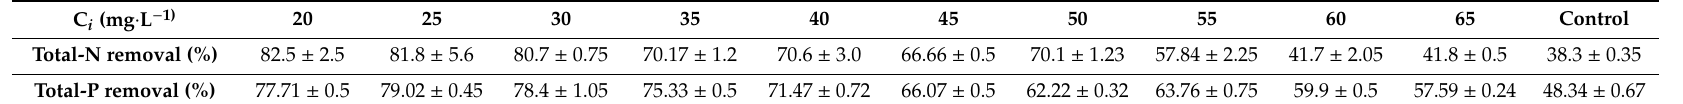
Table 2. The characteristics of SWE after 14 days of Chlorella vulgaris